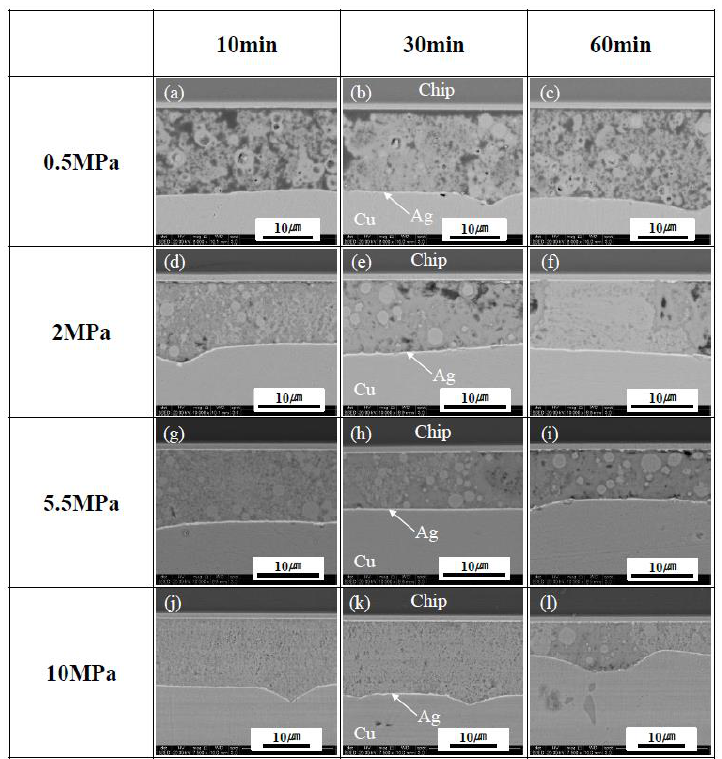
Figure 6. Cross-sectional SEM images of the Si chip/sintered Cu layer/DBC joints at different ◦ C; ( a – c ) 0.5, ( d – f ) 2, ( g – i ) 5.5, and ( j – l ) 10 sintering pressures and durations at 300 °C; ( a – c ) 0.5, ( d – f ) 2, ( g – i ) 5.5, and ( j – l ) 10 MPa. pressures and durations at 300